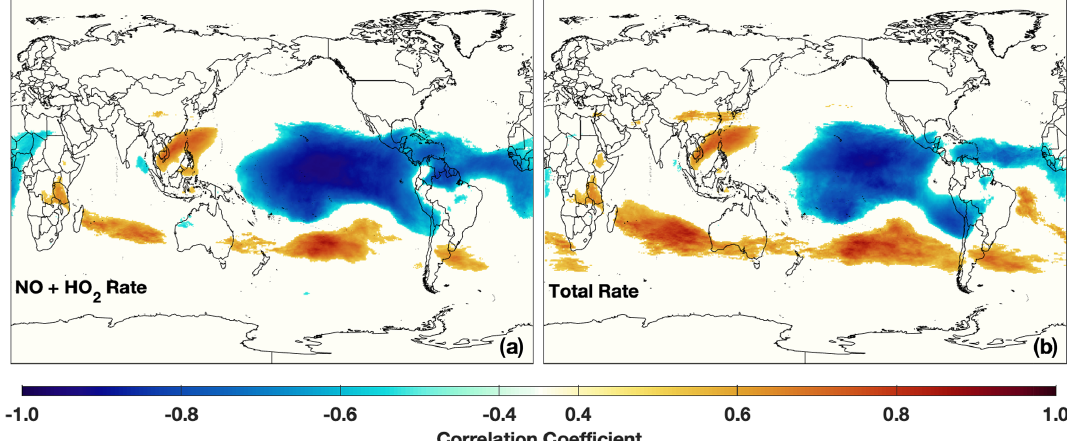
Figure 15. Correlations of the production rate of OH from the NO + HO 2 reaction (a) for DJF and the total OH production rate, as defined in the text (b) with the MEI, for the UFT level are shown.